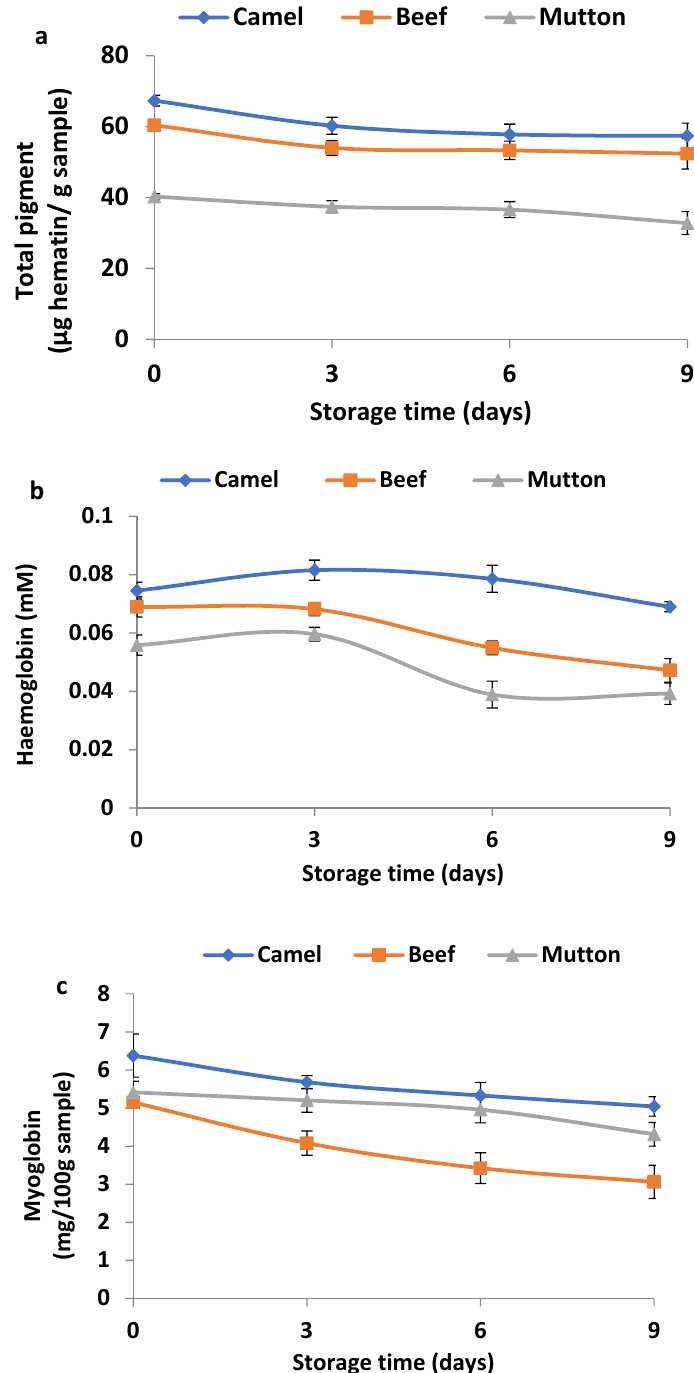
Figure 4. Changes in total pigment ( a ), haemoglobin content ( b ) and myoglobin content ( c ) in camel meat, beef and mutton during 9 days of refrigerated storage. Data are represented as mean ± SEM ( n = 6).